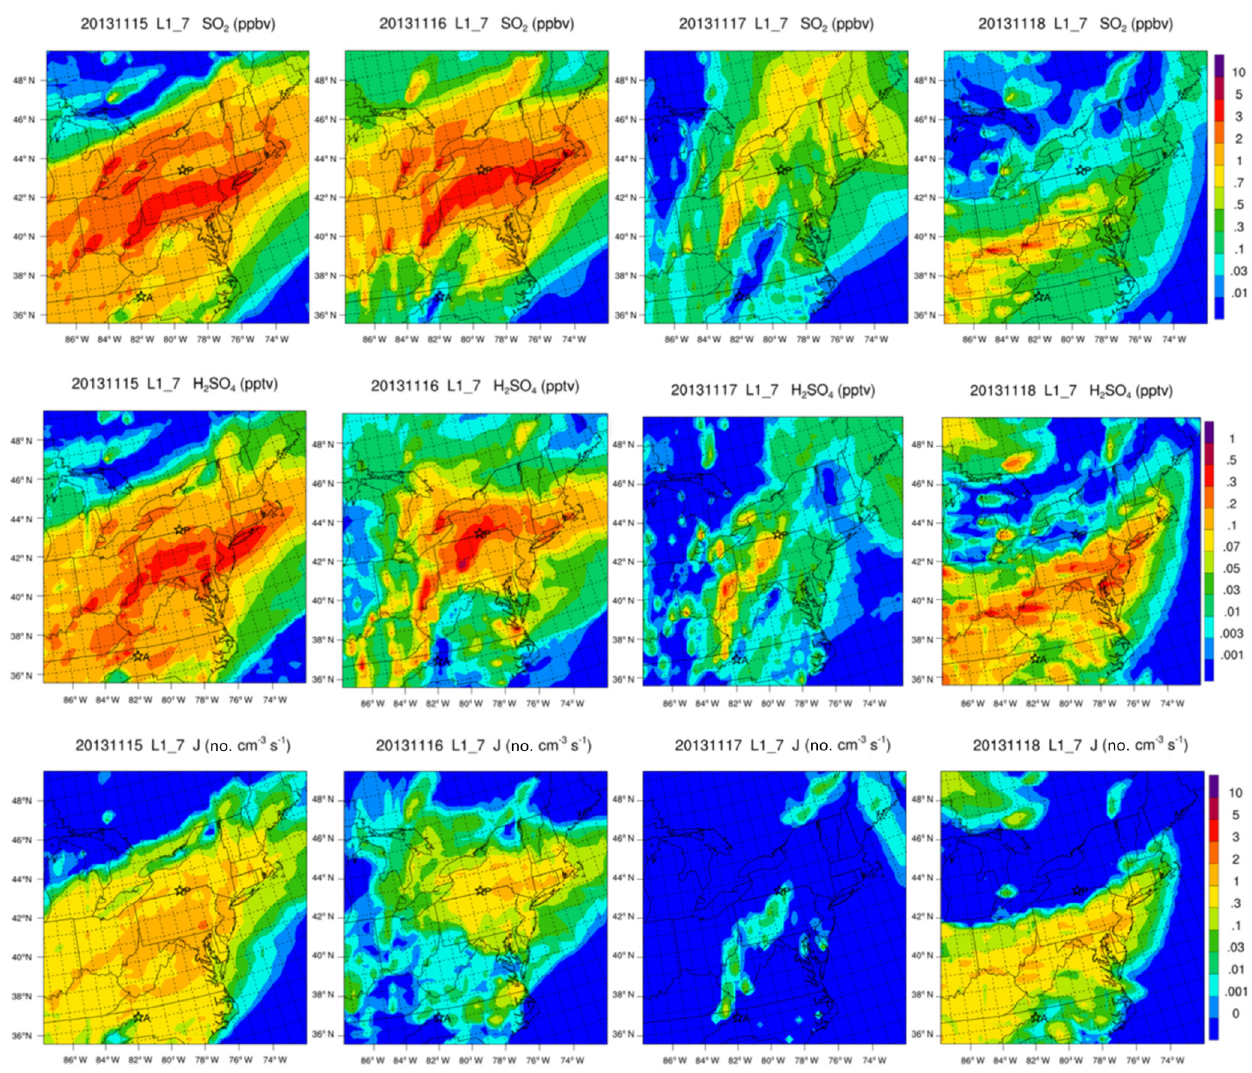
Figure 4. For each day of the 4d period from (left to right) 15–18 November 2013, (top to bottom) modeled horizontal spatial distribution of [SO 2 ], [H 2 SO 4 ], and nucleation rate ( J ) over the NEUS, with the measurement sites Pinnacle State Park (P) and APP (A) marked on the